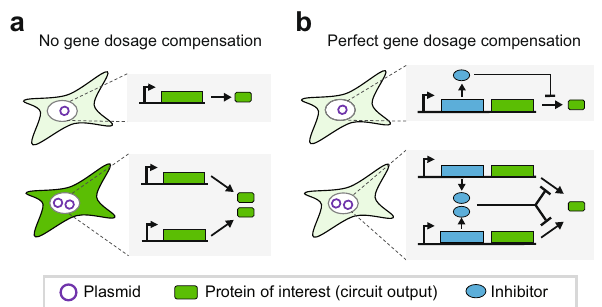
Fig. 1 Gene expression from ideal dosage compensation circuits does not vary with plasmid copy number. a Expression from promoters with no control circuitry (i.e. open-loop circuits) is proportional to the plasmid copy number. b An ideal dosage compensation system uses control mechanisms to tune the per-copy expression rate, thereby maintaining constant expression regardless of copy